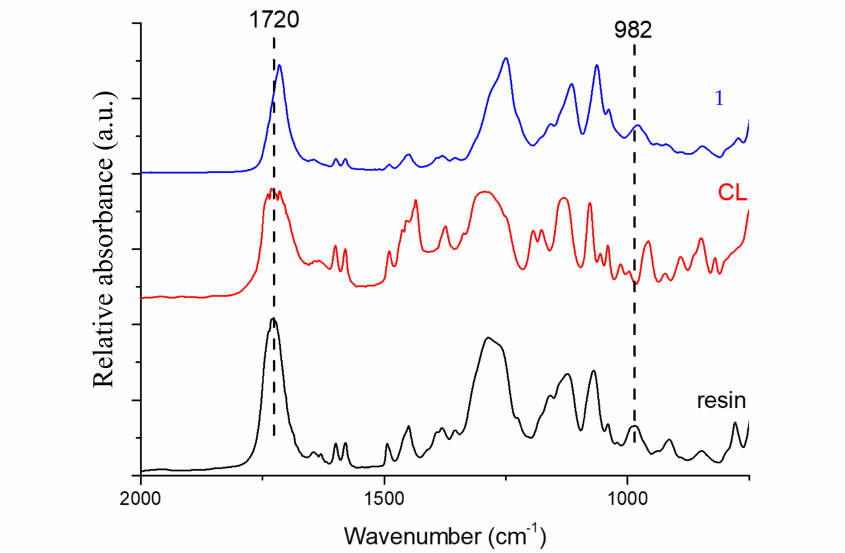
Figure 2. FTIR spectra of the resin, crosslinker (CL) and sample subjected to curing parameter 1.